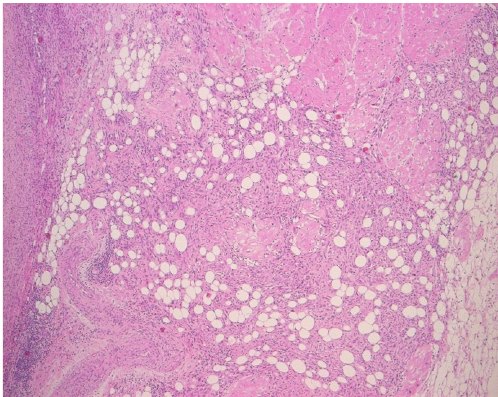
Figure 4: Section shows sheets of densely packed spindle cells infil- trating the myocardium, as well as the overlying epicardial adipose tissue (Stain: H&E, × 5).